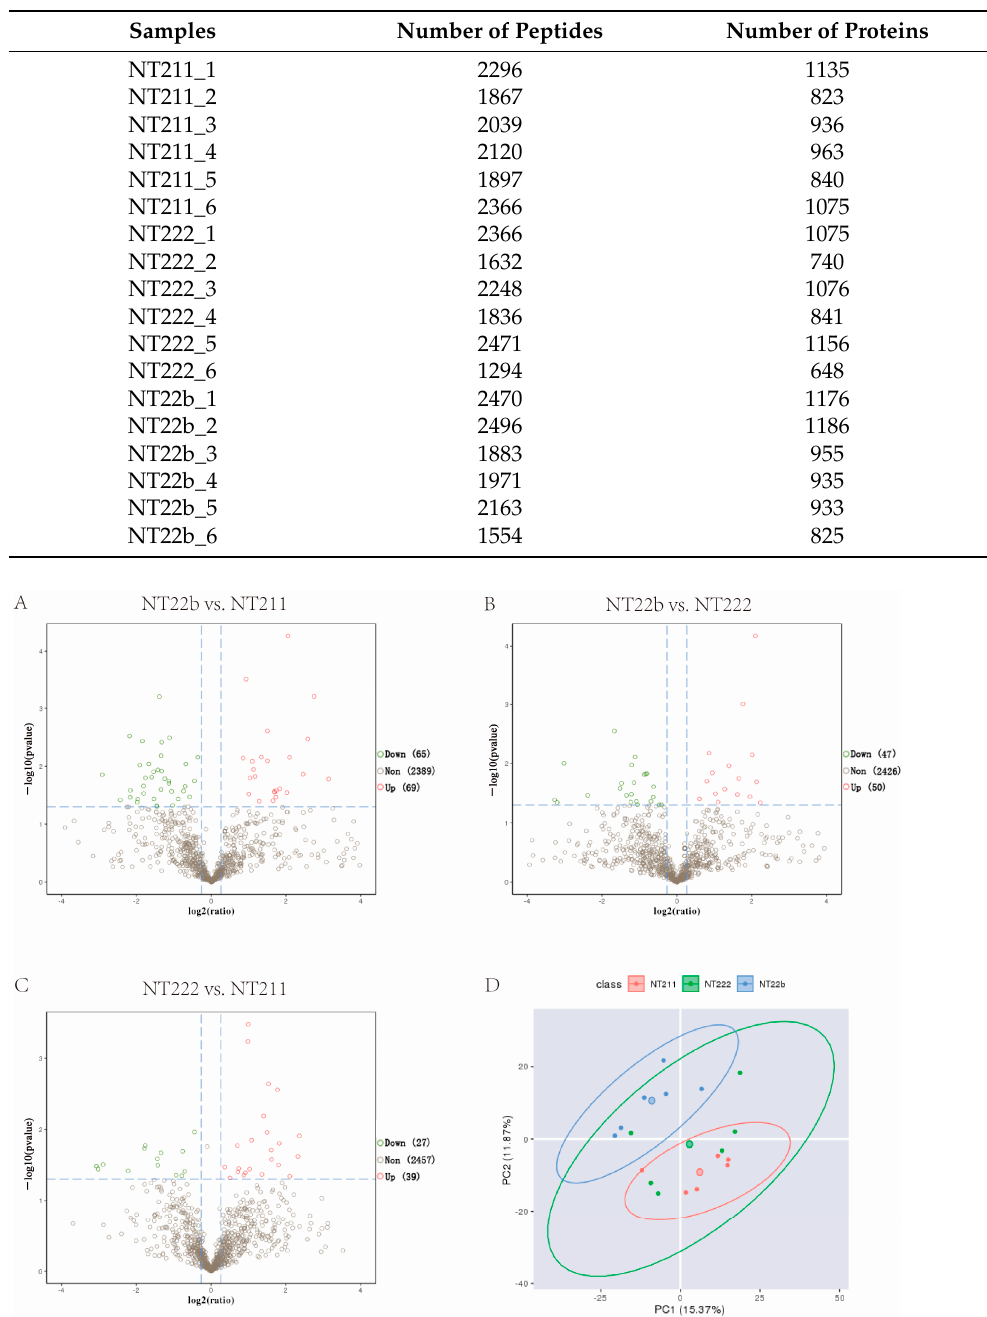
Table 2. Number of peptides and proteins identified by microproteomics.